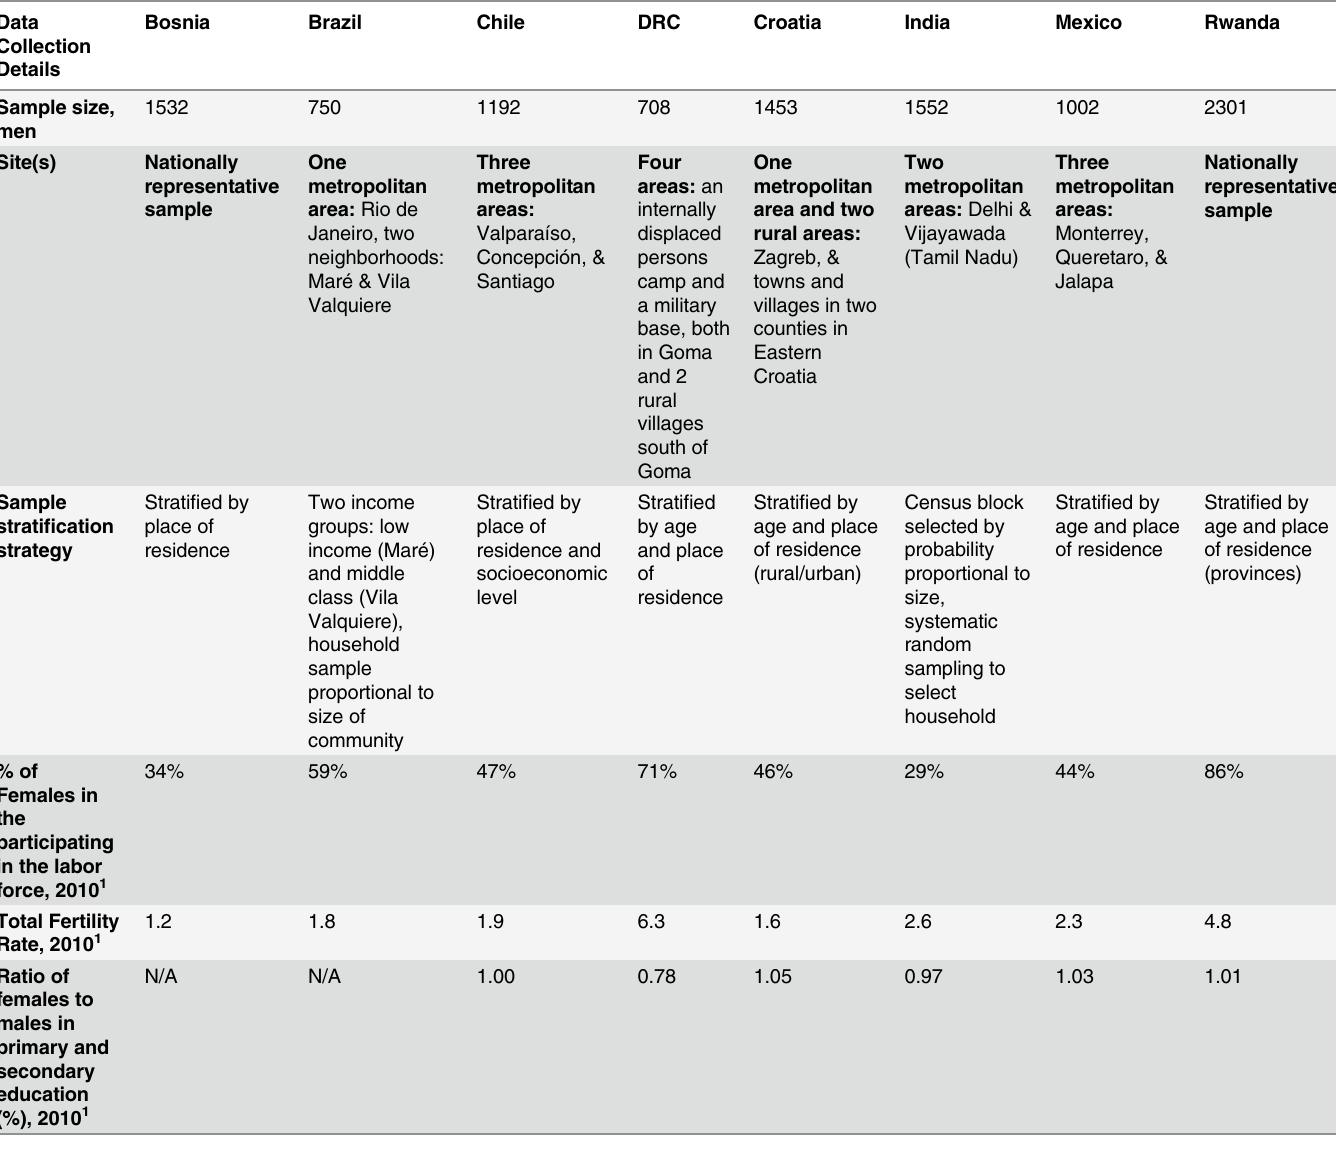
Table 1. Details on data collection in each country (adapted from Barker et al. [32] and Levtov [33]). Data